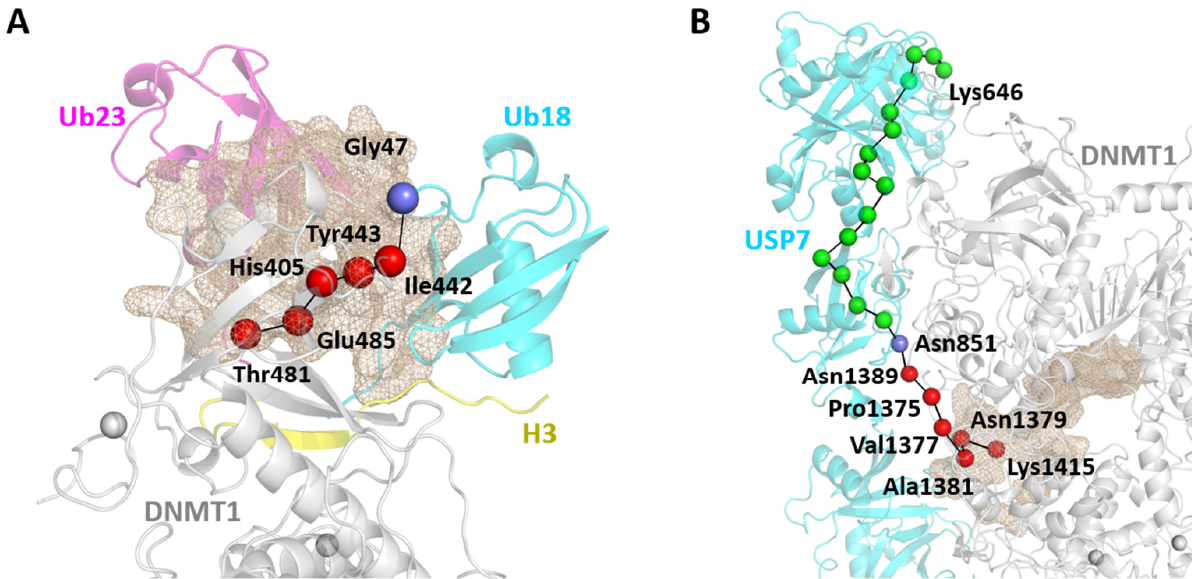
Figure 10. Allosteric pockets and the corresponding communication pathways detected in DNMT1 complexes. ( A ) Pocket 4 in DNMT1-H3Ub and the involved pathway induced by the mutational hotspot Thr481. ( B ) Pocket 3 in DNMT1-USP7 and the involved pathway induced by the PTM site Lys1415. The pockets are shown as wheat contoured meshes. The residues of each pathway are represented by green spheres, where common pathway patterns are highlighted in red (DNMT1) and slate (H3UB.Ub18/USP7).